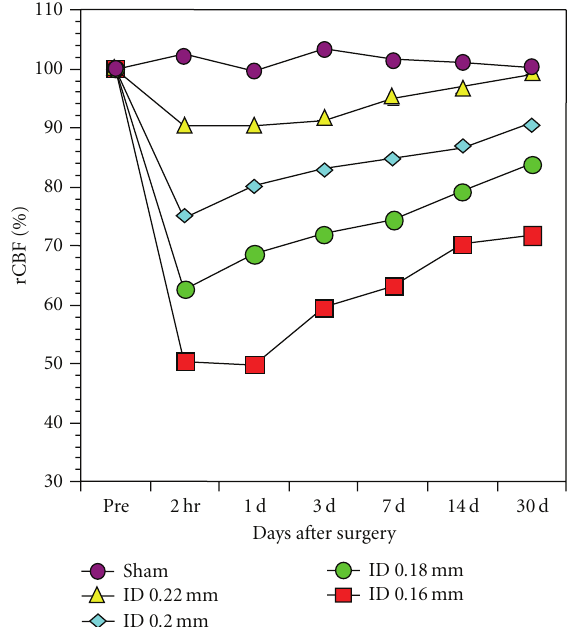
Figure 2: Cerebral blood flow after BCAS. This figure shows cerebral blood flow evaluated with laser Doppler flowmetry in mice at 2.5 months of age after the surgery using microcoils with diameter of 0.16mm, 0.18mm, 0.20mm, and 0.22 mm. The data represent mean values expressed as a percentage of the preoperative